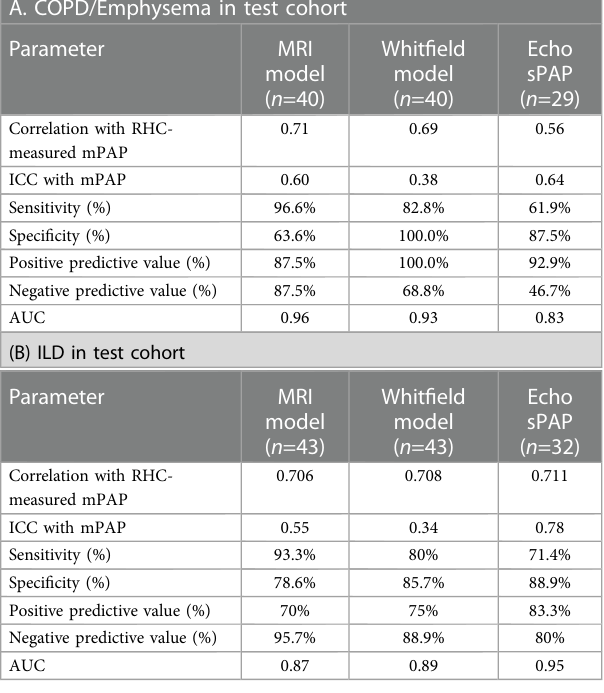
( Table 2 ). Pearson Chi-Square value for the test was 17.18 and Fisher ’ s exact test value was <0.0001.